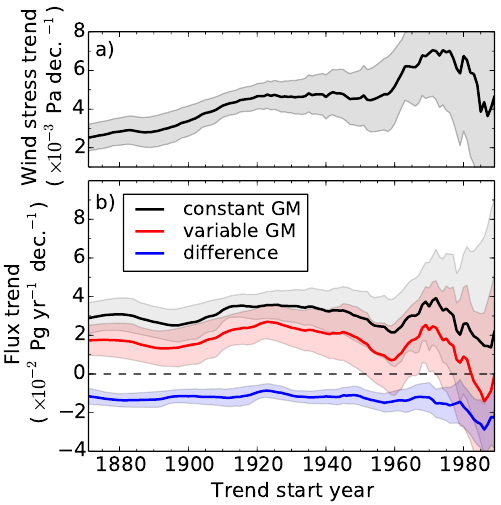
Figure 4. (a) The rolling linear trend in the surface wind stress aver- aged zonally and over 40–60 ◦ S. (b) The rolling trend in the South- ern Ocean (>45 ◦ S) sea–air CO 2 flux anomaly due to wind changes for the constant and variable GM simulations, as well as the differ- ence in trends between the two. The trends are calculated over the period with a start year, which rolls forward from 1871 to 1990 and an end year of 2010. The solid lines show the trend, and the shaded envelopes are the adjusted 5 to 95% confidence